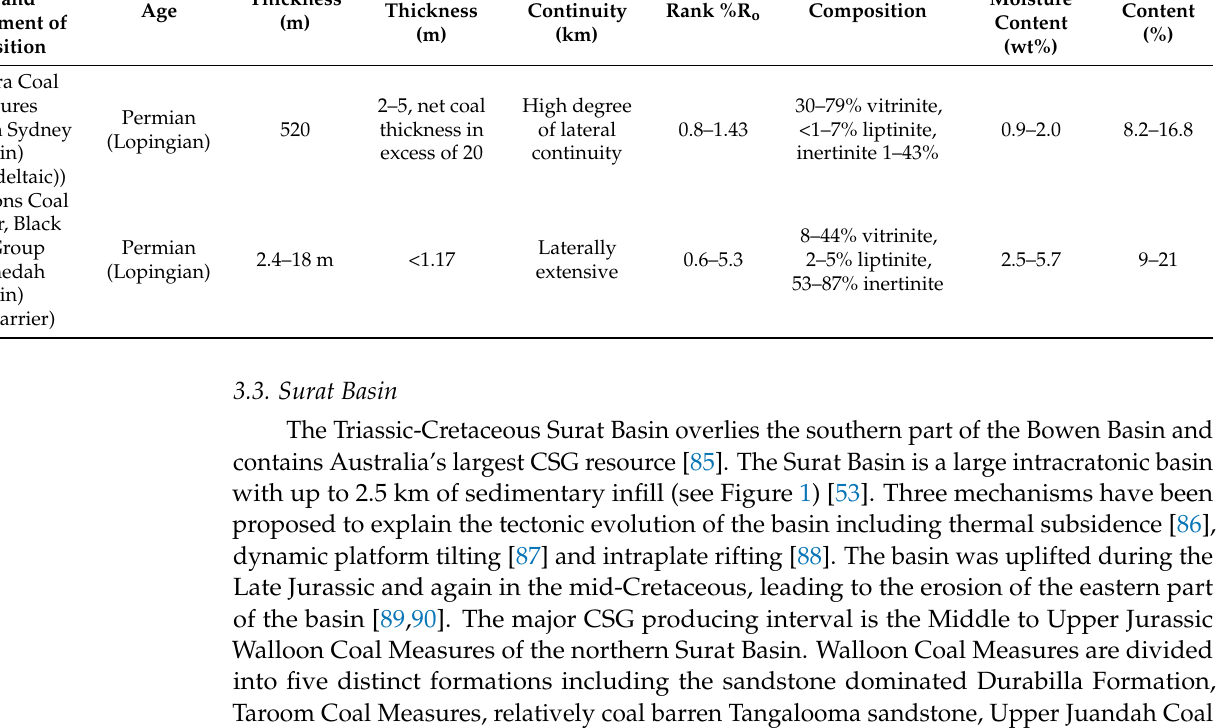
Table 3. Summary of key geological characteristics of CSG-bearing units in the Sydney-Gunnedah Basin [70,73,78–82]. Stratigraphic Unit